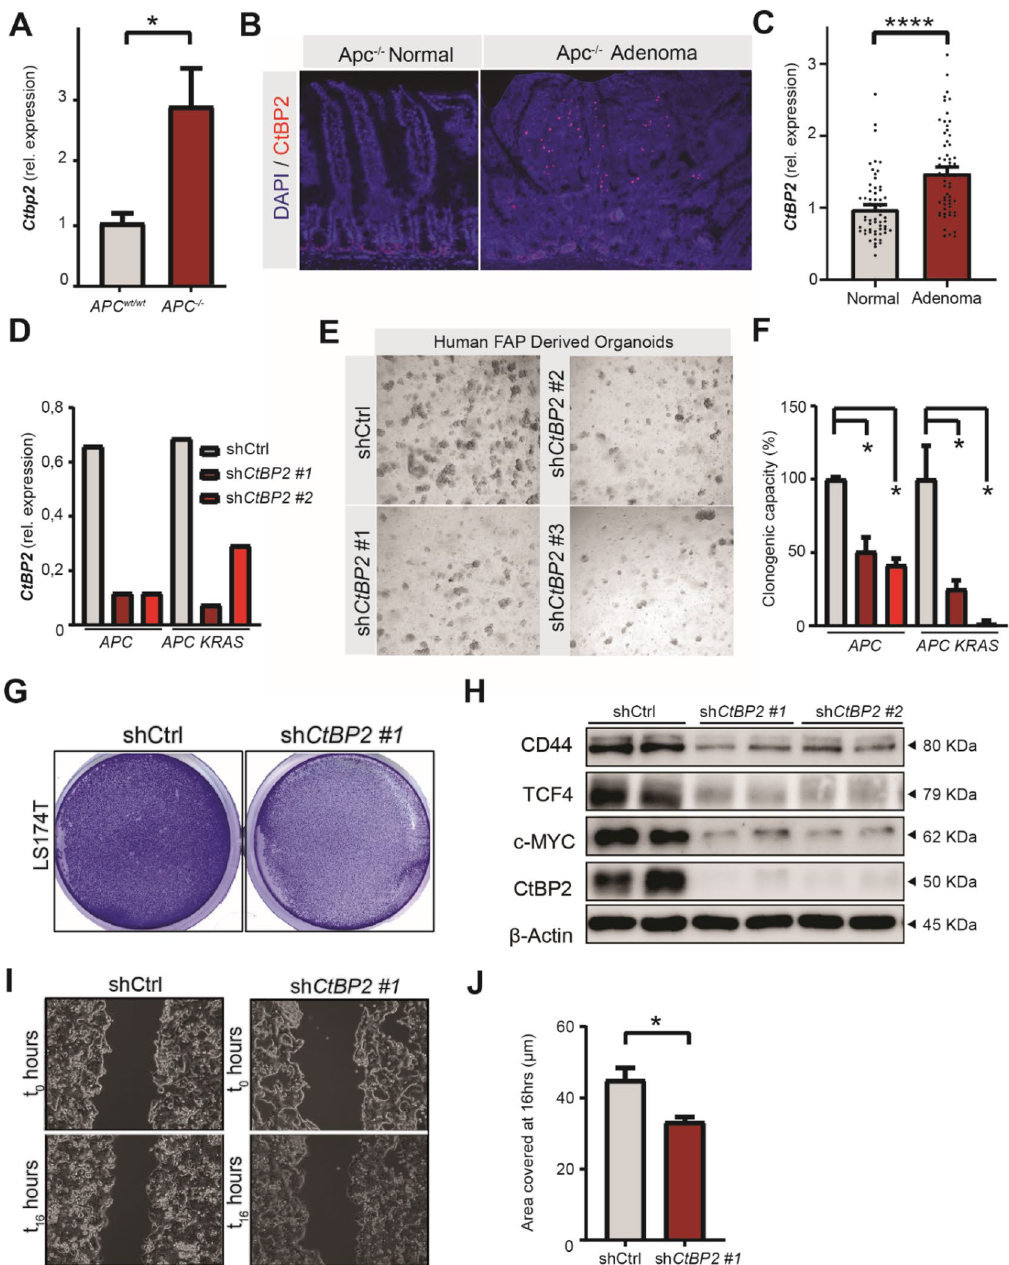
Figure 5. CtBP2 is important for clonal expansion of a WNT-high cancer cell line and colon organoids derived from FAP patients. ( A ) RT-qPCR of Ctbp2 in small intestinal tissue of Apc homozygous mice (n = 4). ( B ) Immunofluorescence for CtBP2 (red) in Apc heterozygous adenoma, with DAPI (blue) counterstain. ( C ) RT-qPCR of CtBP2 in adenomatous tissue of a patient cohort (n = 60 per group). ( D ) Knockdown efficiency measured by RT-qPCR of CtBP2 in FAP patient-derived organoids carrying mutations in APC with and without additional mutations in KRAS . ( E ) Representative images showing outgrowth of FAP patient-derived organoids transduced with shCtBP2 , 72 h after single cell seeding. ( F ) Clonogenic capacity of two FAP patient-derived organoids after knockdown of CtBP2 (n = 2). ( G ) Representative image of crystal violet staining on LS174T cells 5 days after lentiviral transduction with shCtrl or shCtBP2 . ( H ) WNT-associated proteins analyzed by western blot in LS174T cells transduced with shCtrl or shCtBP2 . Full-length blots/gels are presented in Supplementary Immunoblotting Data Figure 6. ( I ) Representative image of migration scratch assay on LS174T cells 5 days after lentiviral transduction with shCtrl or shCtBP2, analyzed immediately after and 16 h after the scratch injury. ( J ) Quantification of covered area of migrating cells 16 h after the scratch injury (n = 3). Images of organoids were captured with a Leica DM6000 microscope using LAS AF software (Leica, Wetzlar, Germany). All western blot images were generated and exported using ImageQuant LAS 4000 software and cropped and labeled using Adobe Illustrator software version 25.2. Graph bars show mean and s.e.m. * P < 0.05, ** P < 0.01, *** P < 0.001, **** P < 0.0001 (Student’s t -test or one-way